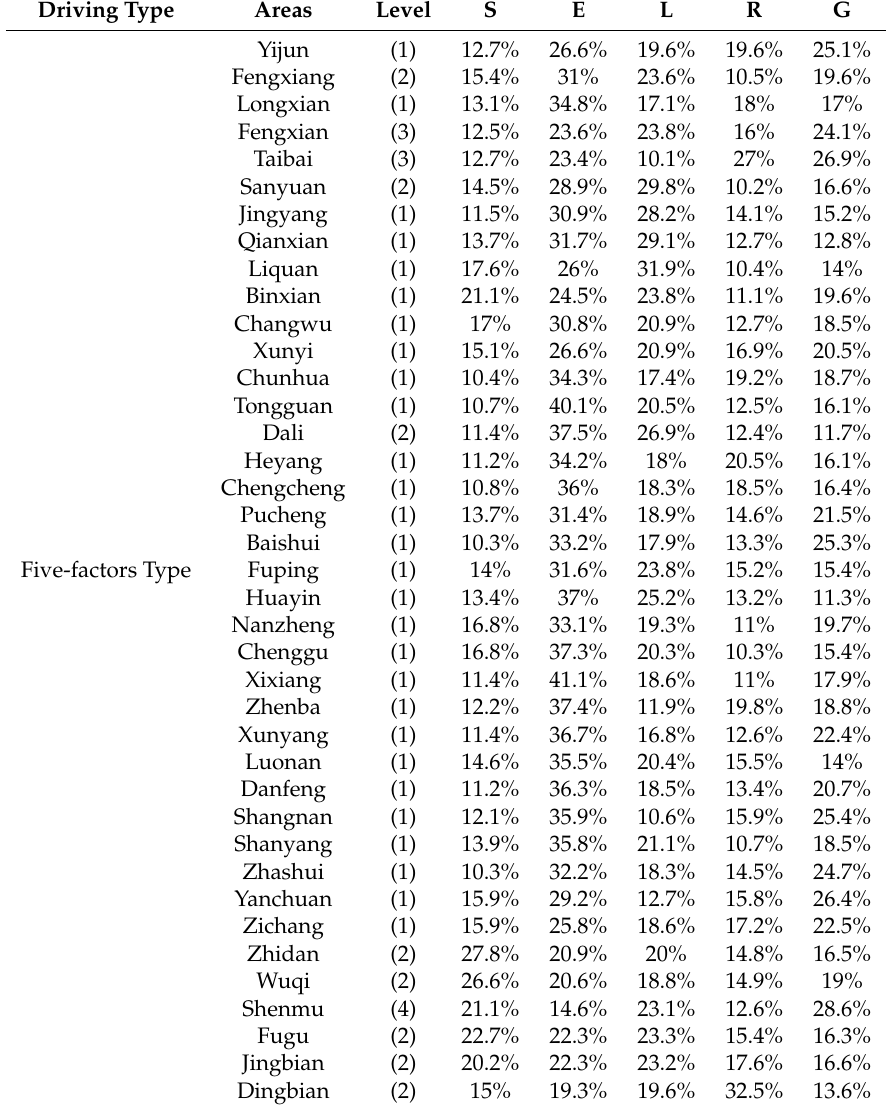
Table 11. Contribution rate of green development driving e ff ect of “Five-Factors Type” areas. Driving Type